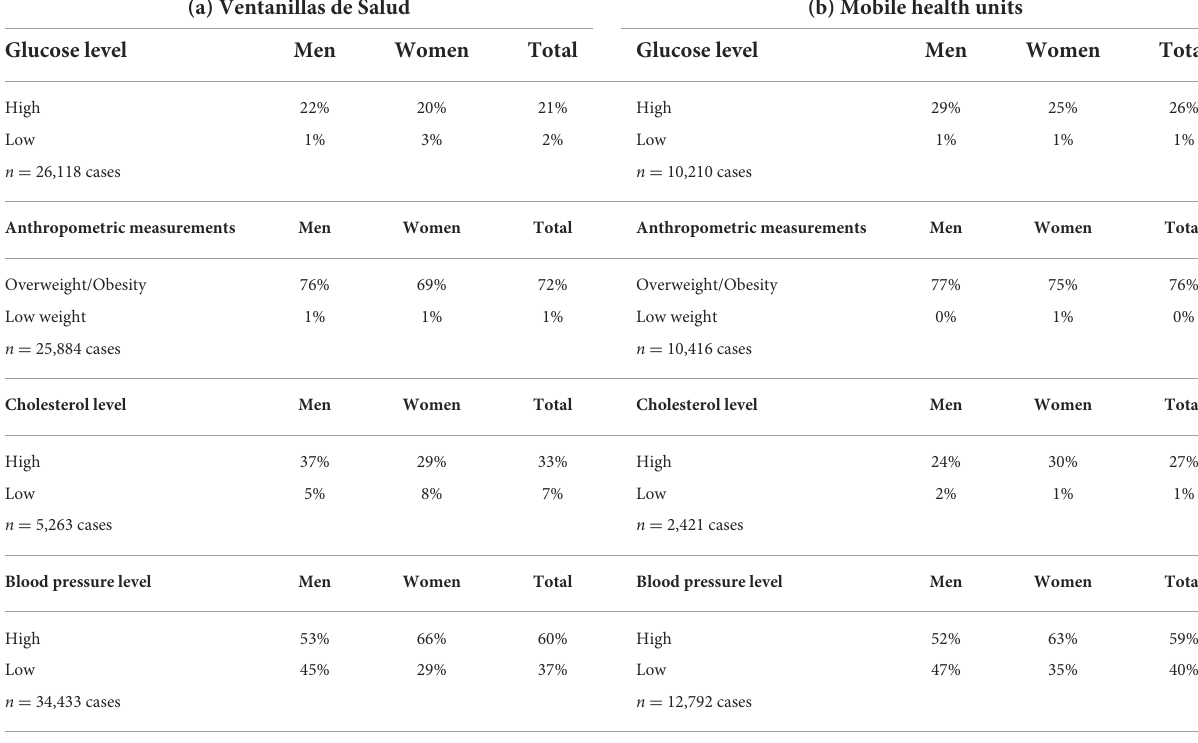
TABLE 3 Percentage distribution of results of anthropometric measurement and glucose, cholesterol, and blood pressure tests, of the population served at VDS and MHU, by sex and type of strategy, January 2019—December 2021 a . (a) Ventanillas de Salud (b) Mobile health units Glucose